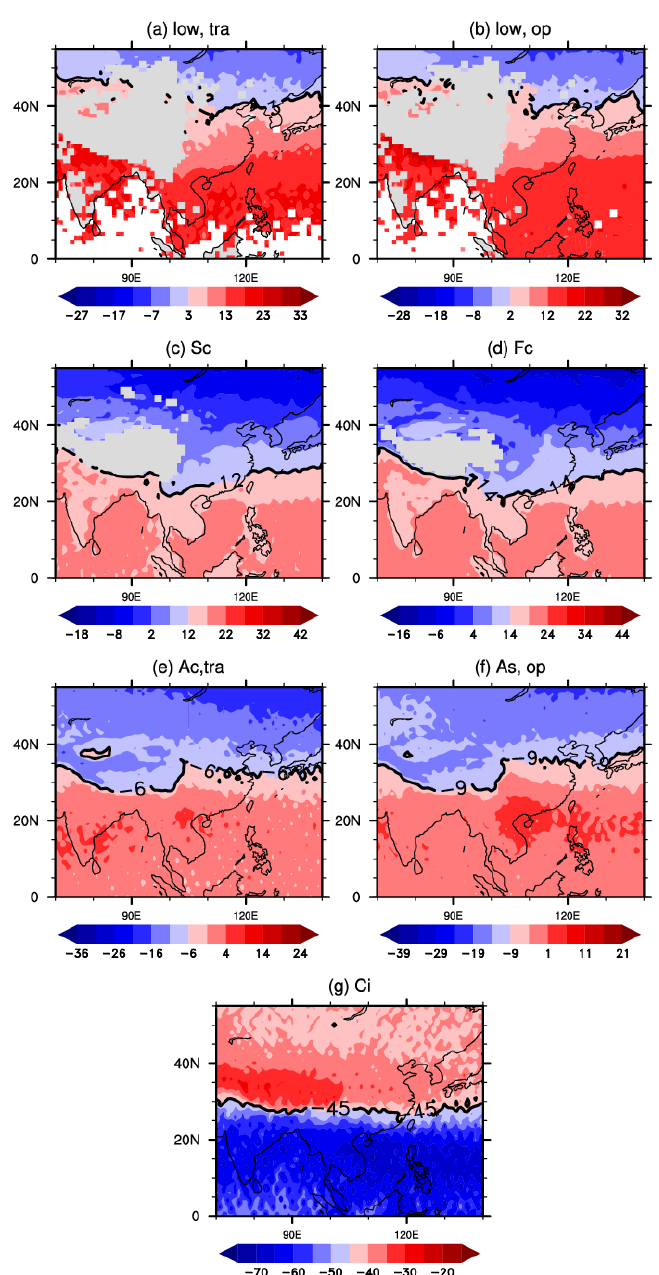
Figure 12. Spatial distribution of temperature in the cloud: ( a ) low overcast (transparent), ( b ) low overcast (opaque), ( c ) stratocumulus, ( d ) low broken cumulus (transparent), ( e ) altocumulus (transparent), ( f ) altostratus (opaque) and ( g ) cirrus. The black thick solid line is the valley temperature, the blue shading is below the valley temperature, and the red shading is above the valley temperature. Unit: °C.